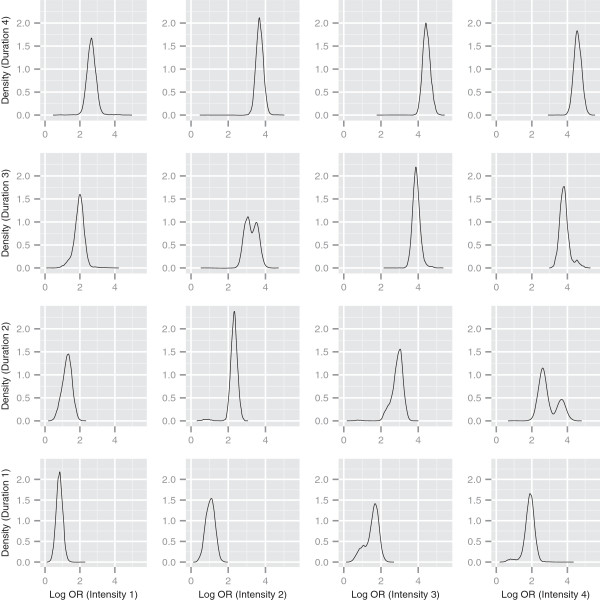
Log odds ratios for intensity and duration combinations. Density estimates of predicted log odds ratios relative to a non-smoking profile, for different intensity and duration combinations. Time since cessation and pack years treated as missing in pseudo-profiles.